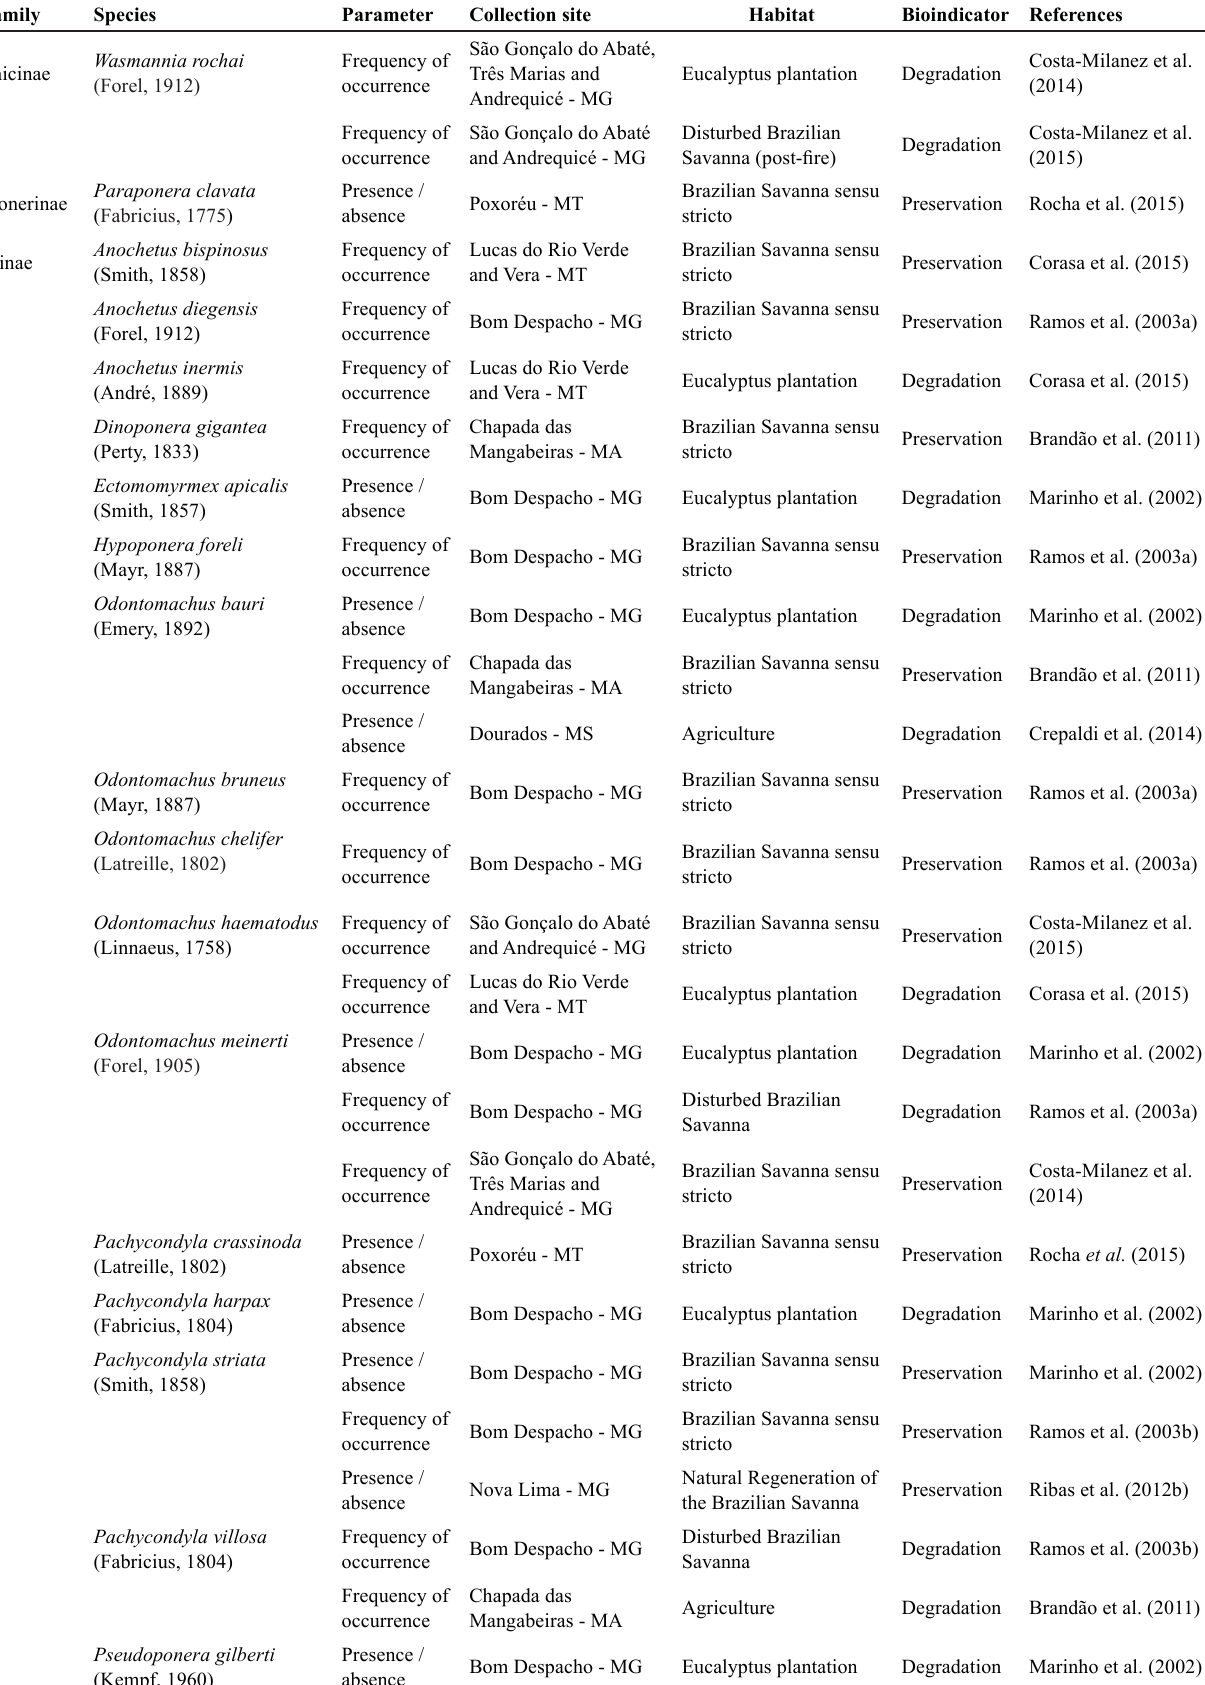
Table 3. Species of ants defined as bioindicators for preservation or degradation in the reference studys, indicating the parameter used to relate to the habitat type, and the reference of the papers analyzed. (Continuation)